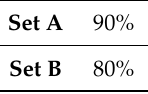
Table 3. Percentages of rounds where the bin was successfully